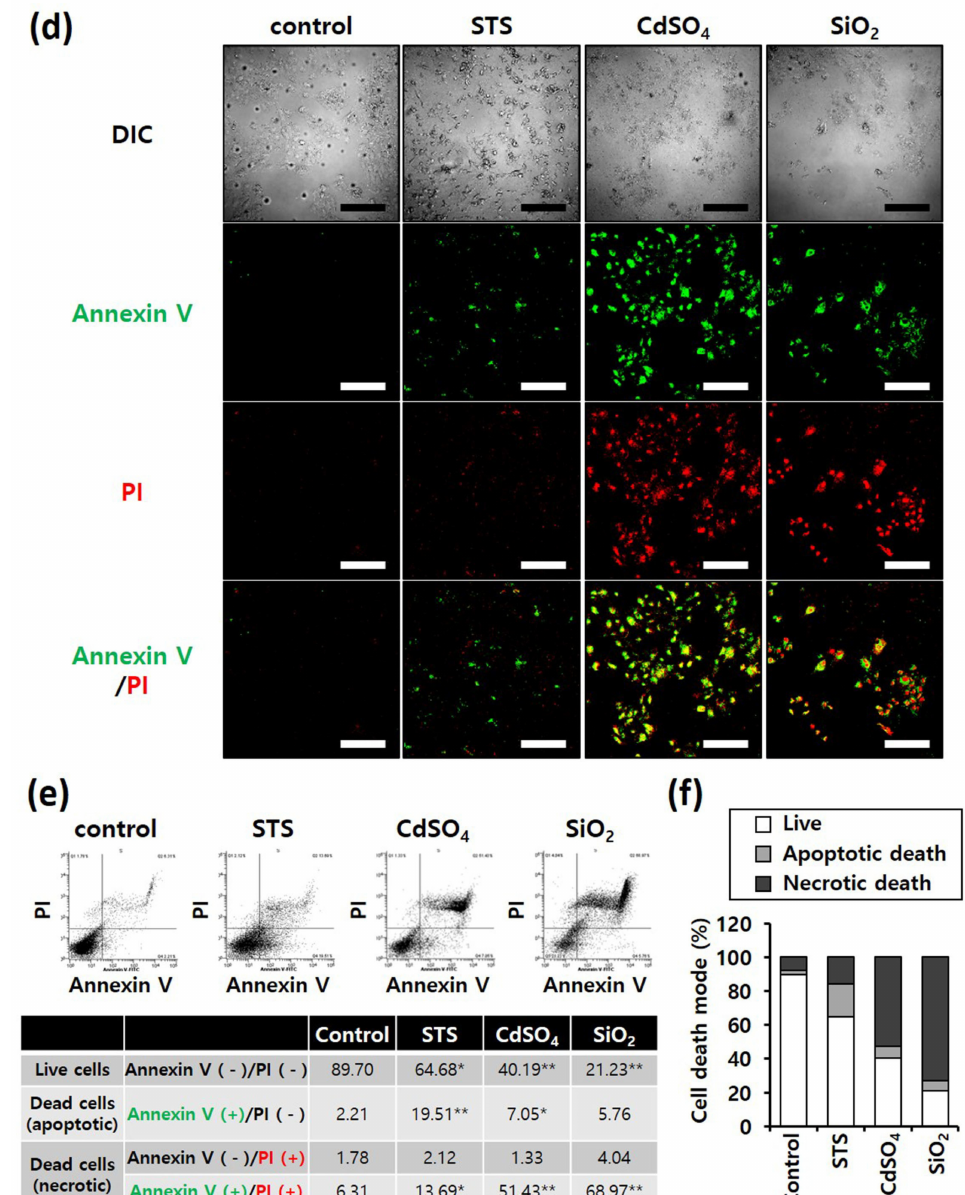
Figure 3. Annexin-V/PI double-staining assay of A549 and NHBE cells; After treating A549 and NHBE cells with SiO 2 NPs (at IC50) and two positive controls, the cells were stained with annexin V-fluorescein isothiocyanate and propidium iodide and analyzed by fluorescence microscopy and flow cytometry. CdSO 4 (1.0 mM) was used to induce necrosis, and staurosporine (STS; 1.0 µ M) was used to induce apoptosis; replicate number = 3. ( a , d ) Confocal fluorescence microscopy images; scale bars represent 200 µ m. ( b , e ) Flow cytometry analysis. * p < 0.05, compared with control; ** p < 0.005, compared with control. ( c , f ) Percentage distribution of necrotic, apoptotic, and viable